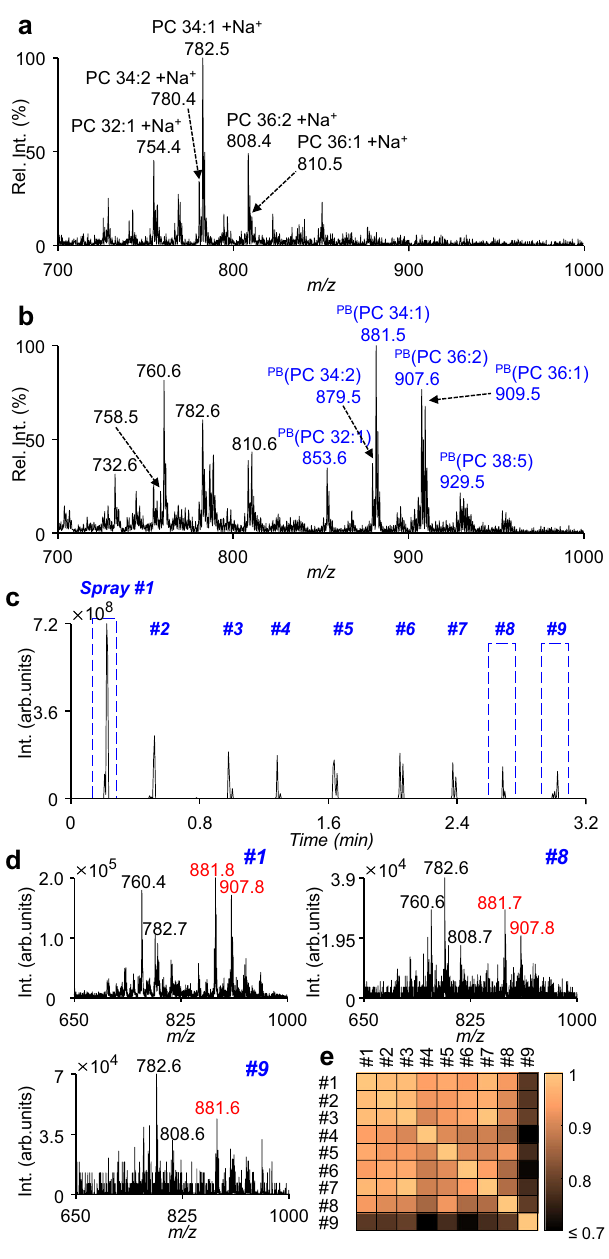
Fig. 2 MS spectrum of a single MDA-MB-231 cell. a , b MS spectra of lipids from a single MDA-MB-231cell without ( a ) and with ( b ) photochemical derivatization (the m/z values in blue: PB products of lipids). c Total ion chromatogram (TIC) of a single MDA-MB-231 cell sampled 9 times by on- demand DAESI-MS after cell fi xation and photochemical derivatization. d Average MS spectra of the 1st, 8th, and 9th samplings (the m/z values in red: PB products of lipids). e Pairwise correlation coef fi cients calculated using the intensities of PB product ions of each spray. Source data are provided in a Source Data fi C18:1 from PC 34:1 to be at Δ 8, Δ 9, or Δ 11 (Fig. 3a). Similarly, MS/MS spectra of [ PB (PC 36:2) + H] + ( m/z 907) indicated that unsaturated fatty acyls in PC 36:2 included C18:1( Δ 8), C18:1( Δ 9), C18:1( Δ 11), and C18:2( Δ 9, 12) (Supplementary Fig. 7). Other